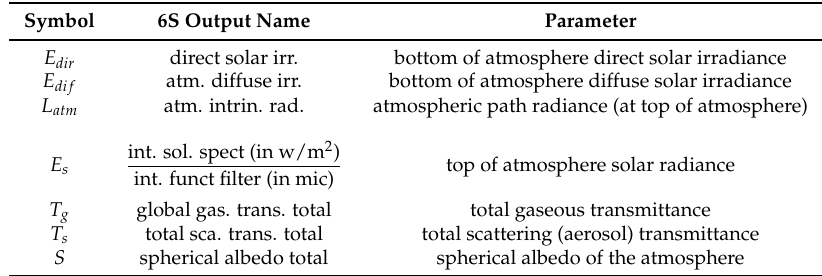
Table A1. 6S atmospheric model output parameters and their symbols used in this